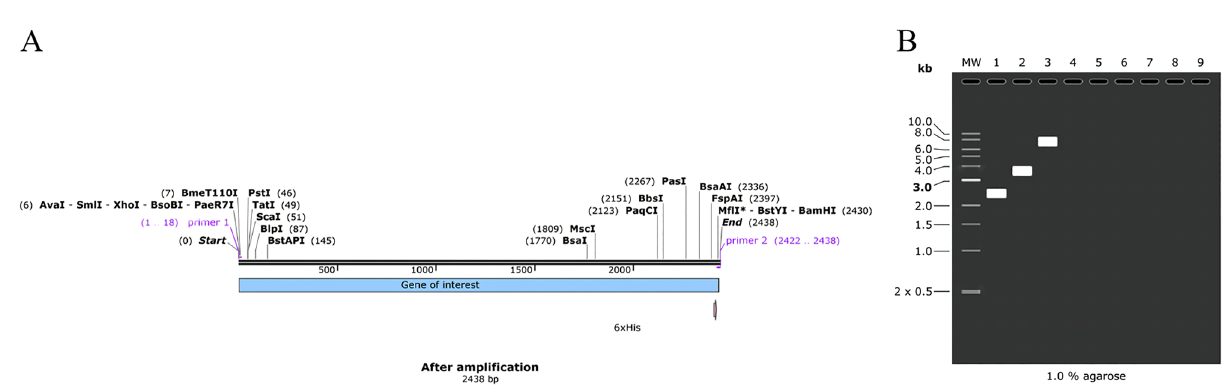
Figure 12. ( A ) Adaptation of optimized codons. ( B ) The MEV (blue) was inserted into the pET28a (+) vector (black) in silico cloning. The codon-optimized sequence of MEV (2418 bp) generated by the JCat server was inserted between XhoI (158) and BamHI (2582), forming a clone (7753 bp) using the SnapGene.